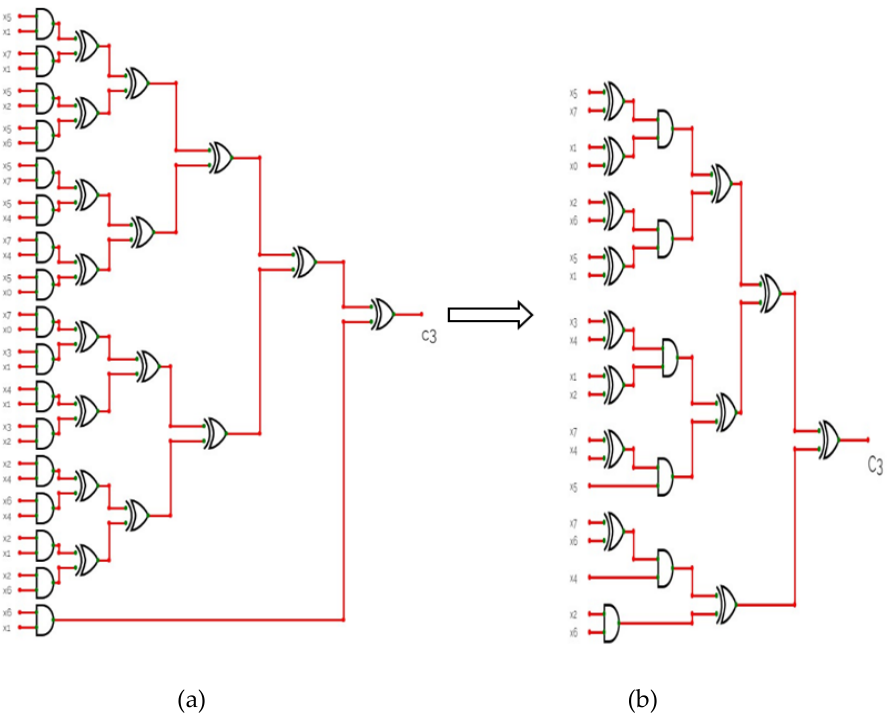
Figure 6. Architectural diagram, ( a ) PPRM architecture and ( b ) MPPRM architecture.